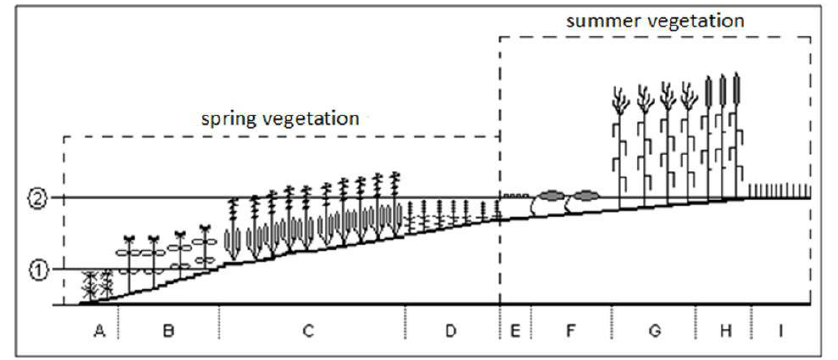
Figure 4. Transect of the main aquatic and marsh communities related to the water level during spring (1) and summer (2). A, Charetum vulgaris ; B, Helosciadietum nodiflori ; C, Rumici maritimi-Ranunculetum scelerati ; D, Filaginello uliginosae-Veronicetum peregrinae ; E, Lemnetum gibbae ; F, Potamogetonetum nodosi and/or Ceratophylletum demersi ; G, Polygono salicifolii-Phragmitetum communis ; H – Typha sp.pl. associations; I, Bidenti tripartitae-Polygonetum mitis and damp meadows of the Molinio-Arrhenatheretea class.